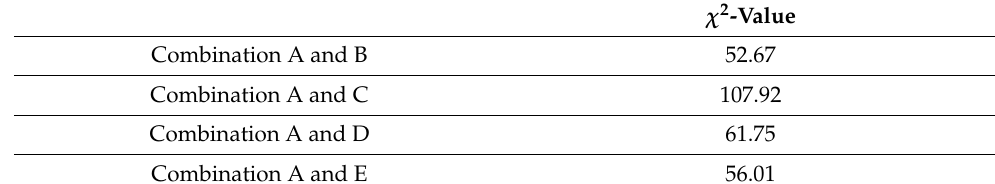
Figure 10. Water extraction results of FFEDN with different combinations in three selected regions. Table 9. Result of McNemar test.